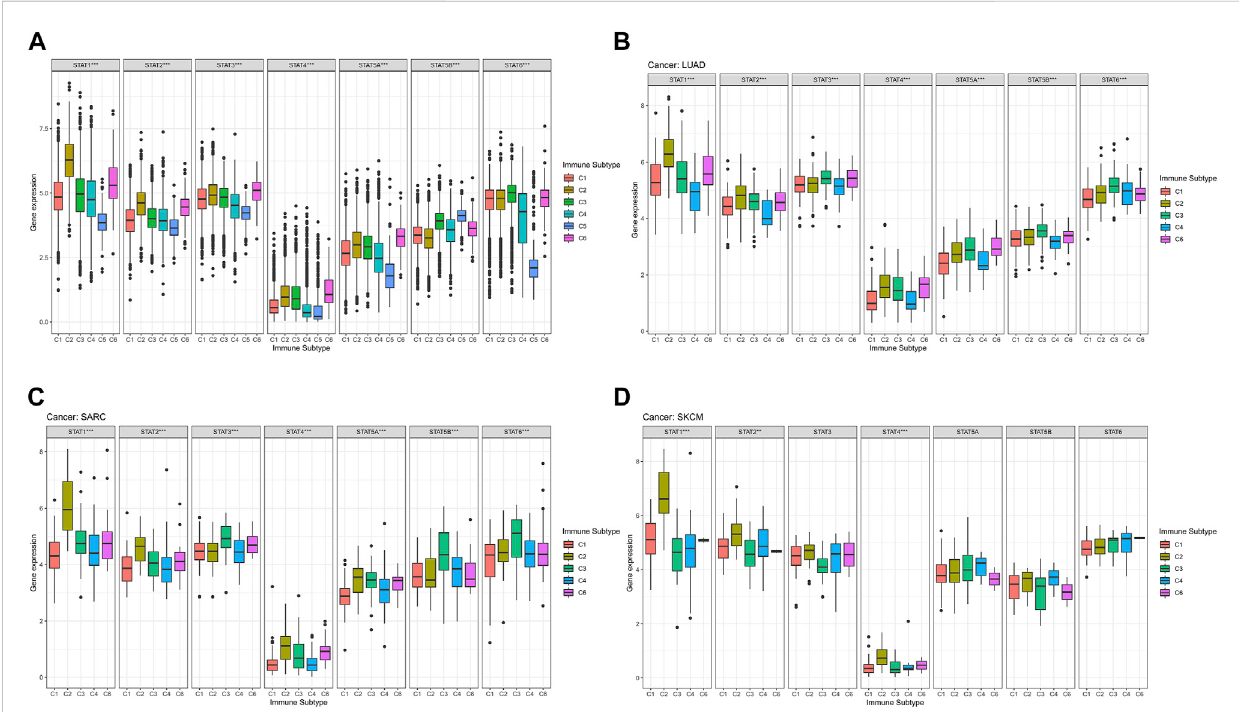
FIGURE 4 Immune subtype analysis of STATs inpan-cancer. (A) Boxplots showed thedifferentialexpressionofaverageexpression levels of STAT1( p < 0.001), STAT2 ( p < 0.001), STAT3 ( p < 0.001), STAT4 ( p < 0.001), STAT5A ( p < 0.001), STAT5B ( p < 0.001), and STAT6 ( p < 0.001) across TCGA cancers among C1- C6immunesubtypes. (B) Boxplotsdisplayedsigni fi cantdifferencesinexpressionlevels ofSTAT1( p < 0.001),STAT2 ( p < 0.001), STAT3( p < 0.001), STAT4 ( p < 0.001), STAT5A ( p < 0.001), STAT5B ( p < 0.001), and STAT6 ( p < 0.001) among immune subtypes C1, C2, C3, C4, and C6 in LUAD. (C) Box plots revealed signi fi cant differences in expression levels of STAT1 ( p < 0.001), STAT2 ( p < 0.001), STAT3 ( p < 0.001), STAT4 ( p < 0.001), STAT5A ( p < 0.001), STAT5B( p < 0.001),andSTAT6( p < 0.001)amongimmunesubtypesC1,C2,C3,C4,andC6inSARC. (D) Boxplotsdemonstratedsigni fi cantdifferencesin expression levels of STAT1 ( p < 0.001), STAT2 ( p < 0.01), and STAT4 ( p < 0.001) among immune subtypes C1, C2, C3, C4, and C6 in